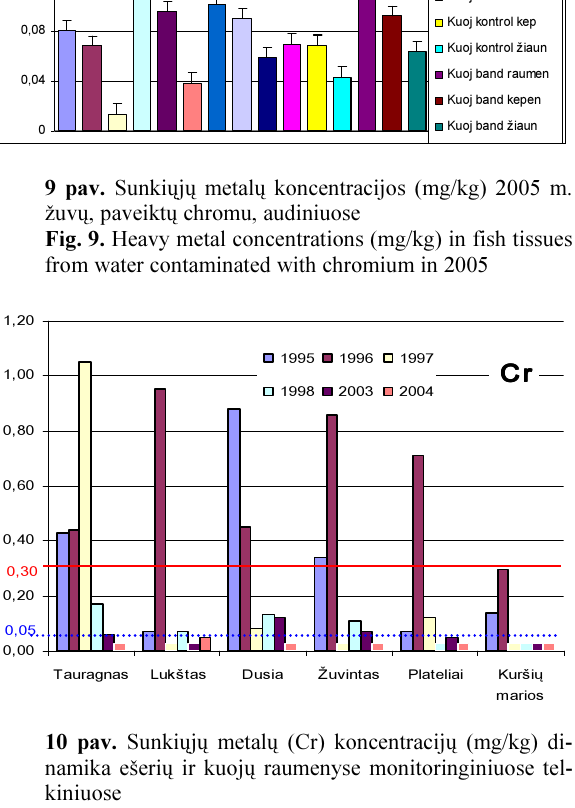
Fig. 12. Dynamic of heavy metal (Pb) concentrations (mg/kg) in perch and roach muscles from monitored water Palyginus kontrolines ir paveiktas žuvų grupes nusta- tyta, kad kadmio k paveiktų žuvų grupės audiniuose padi- dėjo: ešerių raumenyse I – nuo 0,04 mg/kg iki 0,06 mg/kg